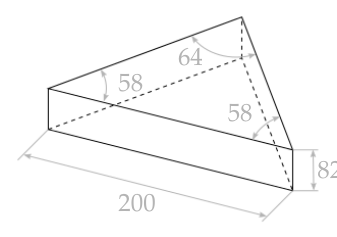
Figure 11. Sketch of the triangular prism used for the experiment. The units are millimetres for the distances and degrees for the angles.